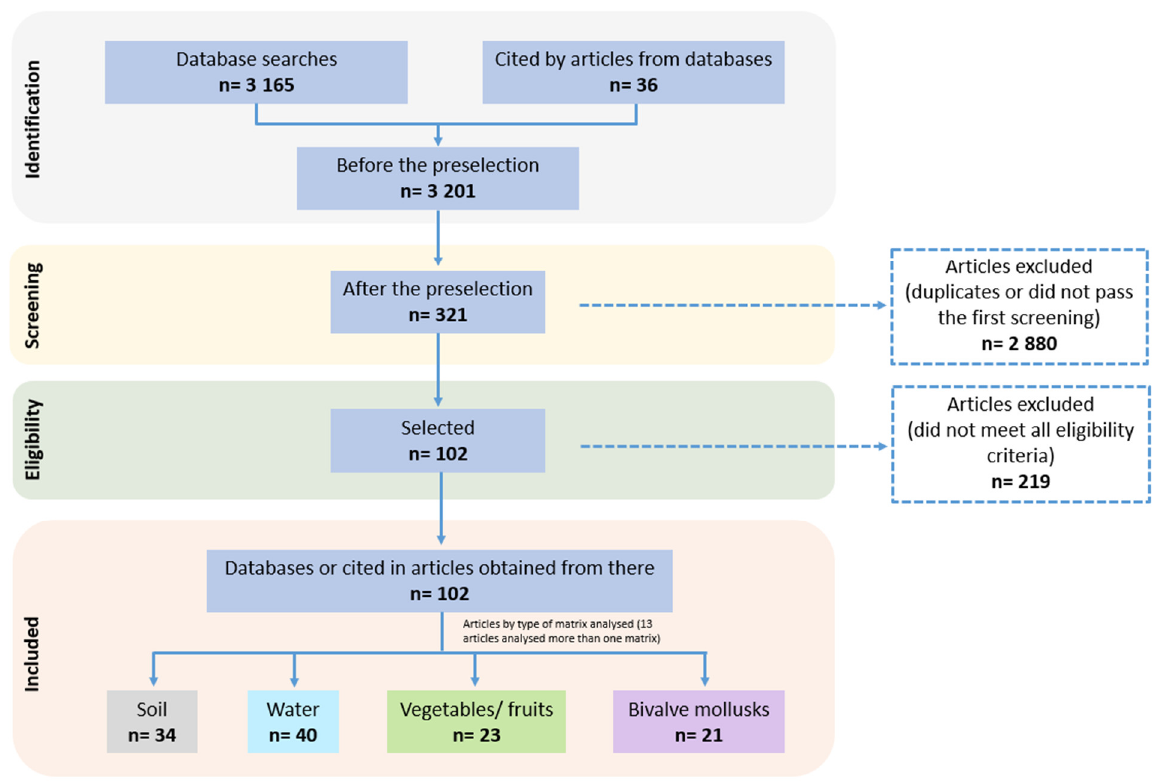
Figure 1. Four-step flow diagram of the systematic review of the presence of Toxoplasma gondii oocysts in soil, water, vegetables, fruit, and bivalve mollusks worldwide until the end of 2020.